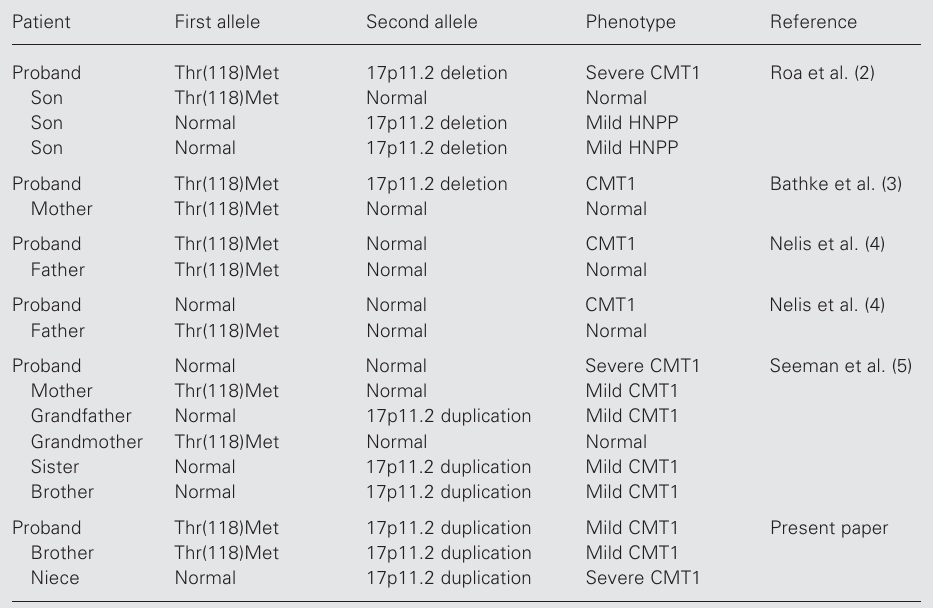
Table 1. Phenotypes and genotypes associated with Thr(118)Met substitution in the reported